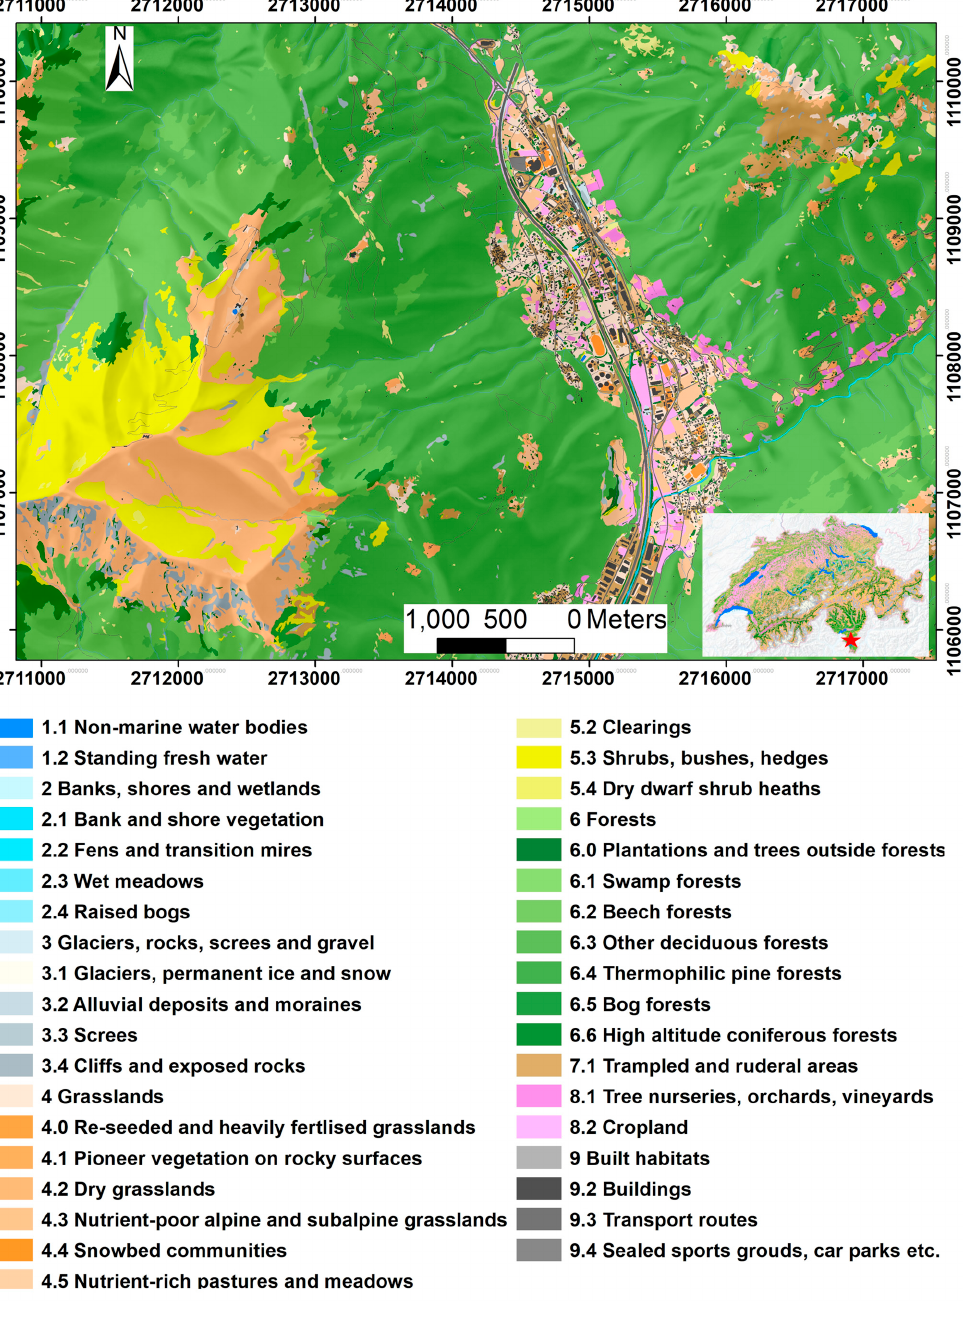
Figure 2. The Habitat Map of Switzerland in three regions of Switzerland, overlaid on the open access swissalti3D topographical relief map [37].